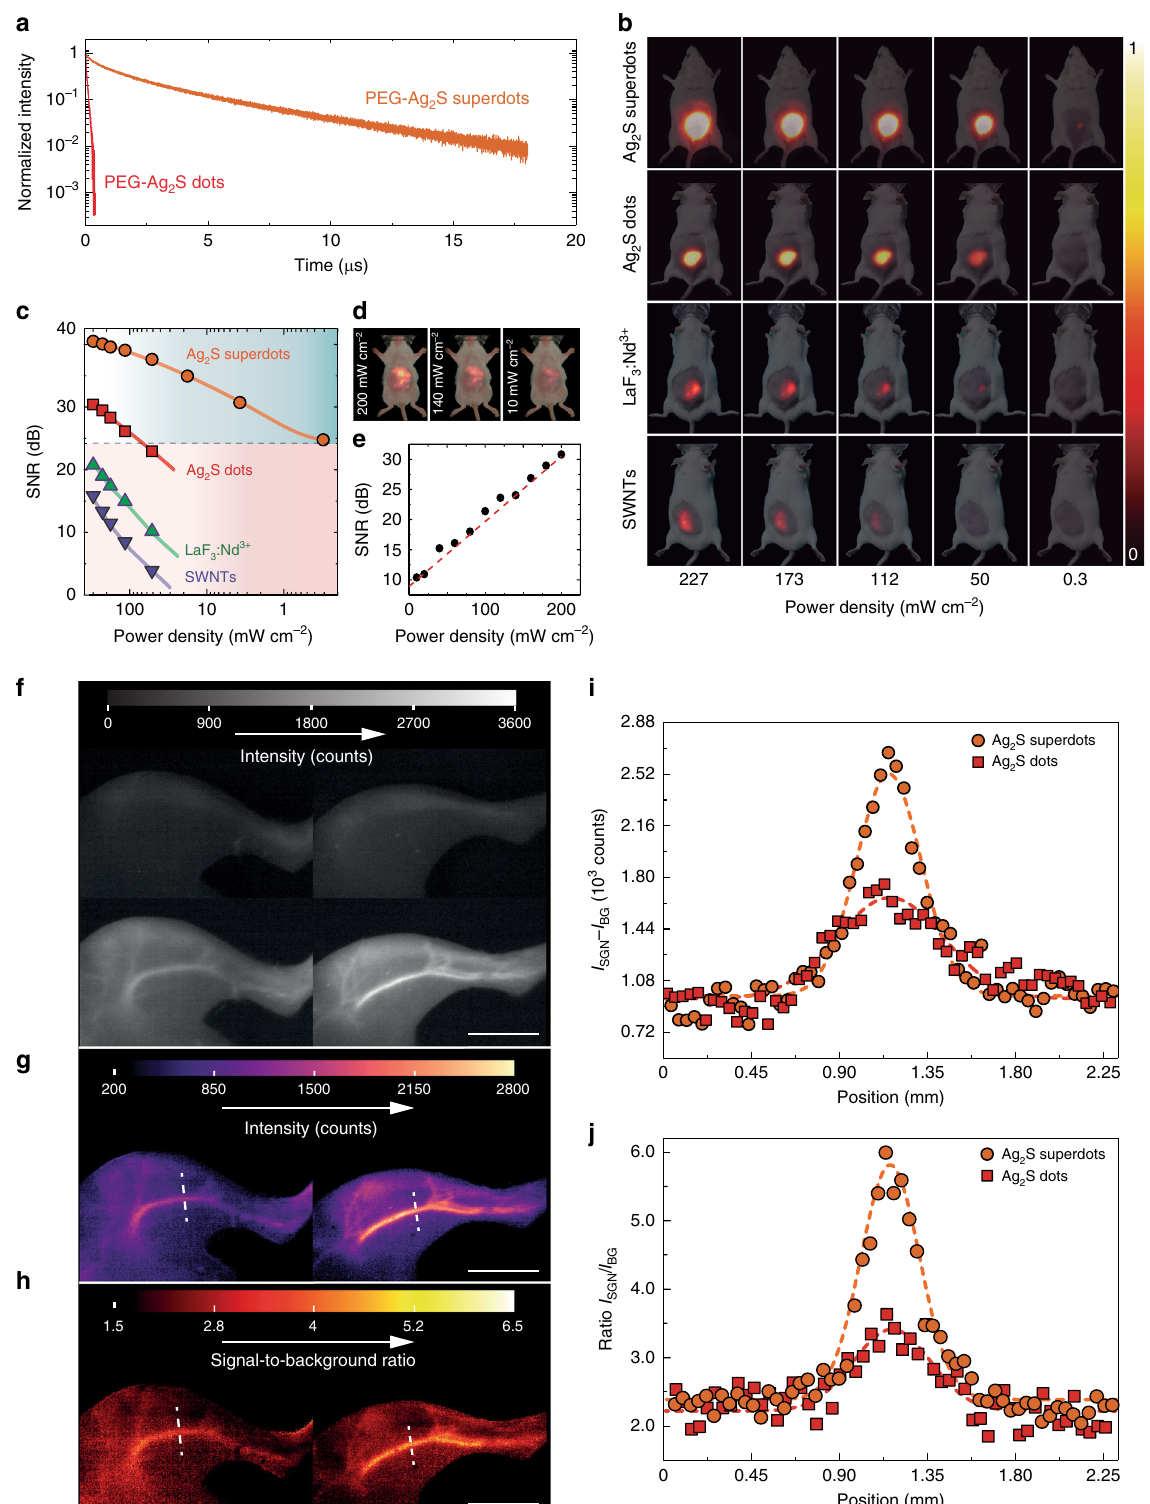
fl uorescence decay curve obtained from commercially available (Sinano Corp. China) PEG-coated Ag 2 S dots dispersed in PBS. These show a fl uorescence lifetime of 53 ns, about 40 times shorter than that of PBS-dispersed PEG-coated Ag 2 S superdots. Such a long fl uorescence lifetime and high QY suggests the potential application of PEGylated Ag 2 S superdots for high- contrast, low-dose NIR-II in vivo